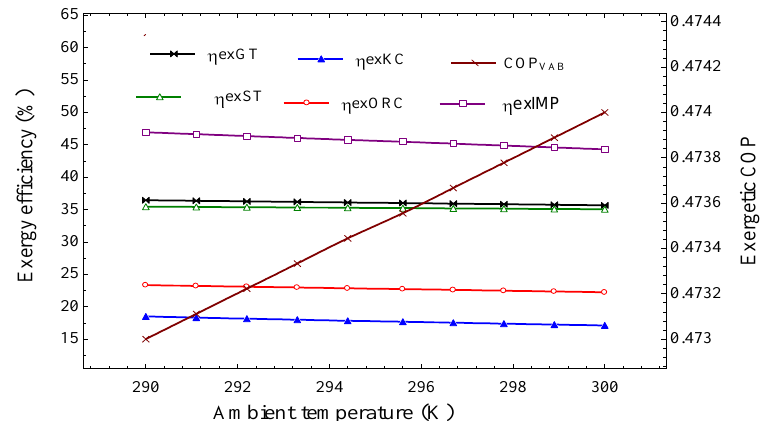
Figure 2. Effect of ambient temperature (AT) variations on the exergy efficiency of the subsystems Figure 2. E ff ect of ambient temperature (AT) variations on the exergy e ffi ciency of the subsystems and and the IMP. the IMP.